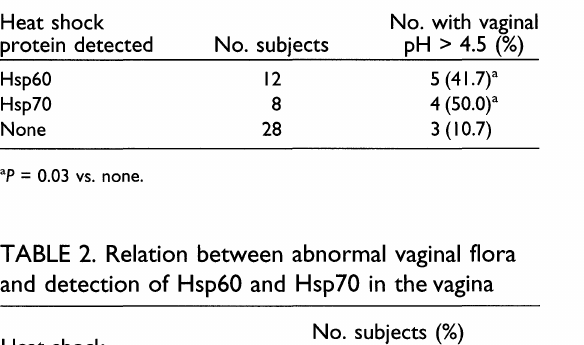
TABLE 2. Relation between abnormal vaginal flora and detection of Hsp60 and Hsp70 in the vagina Heat shock